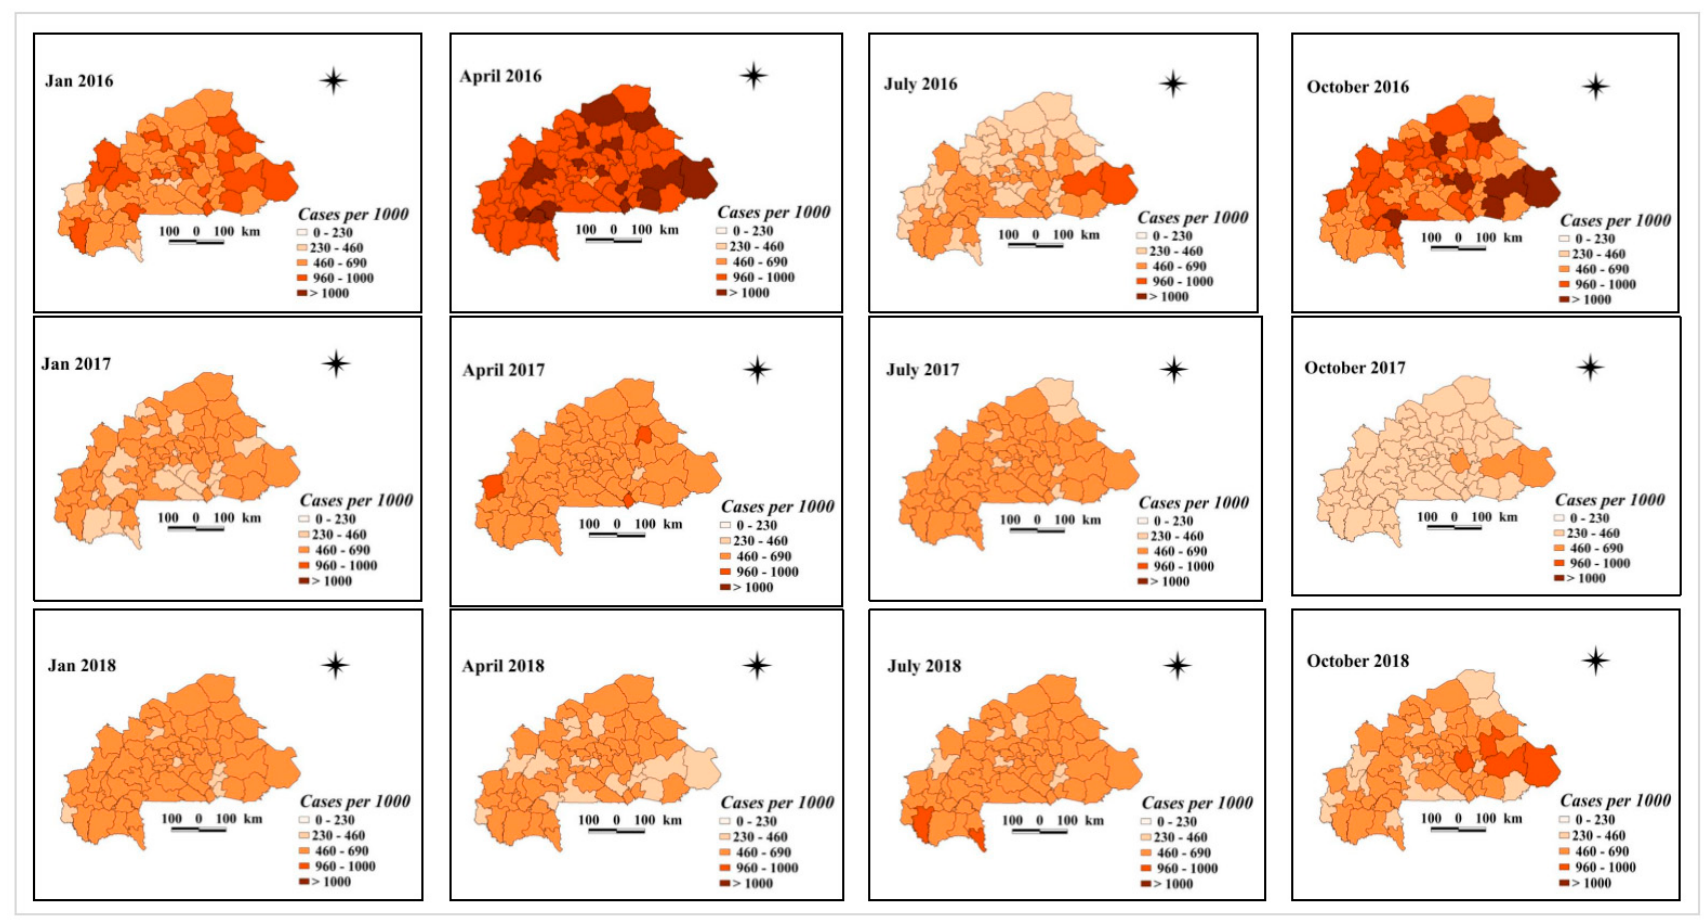
Figure 3. Space–time patterns of tested malaria incidence (cases per 1000 children) in children less than 5 years estimated from the Bayesian spatio-temporal model.